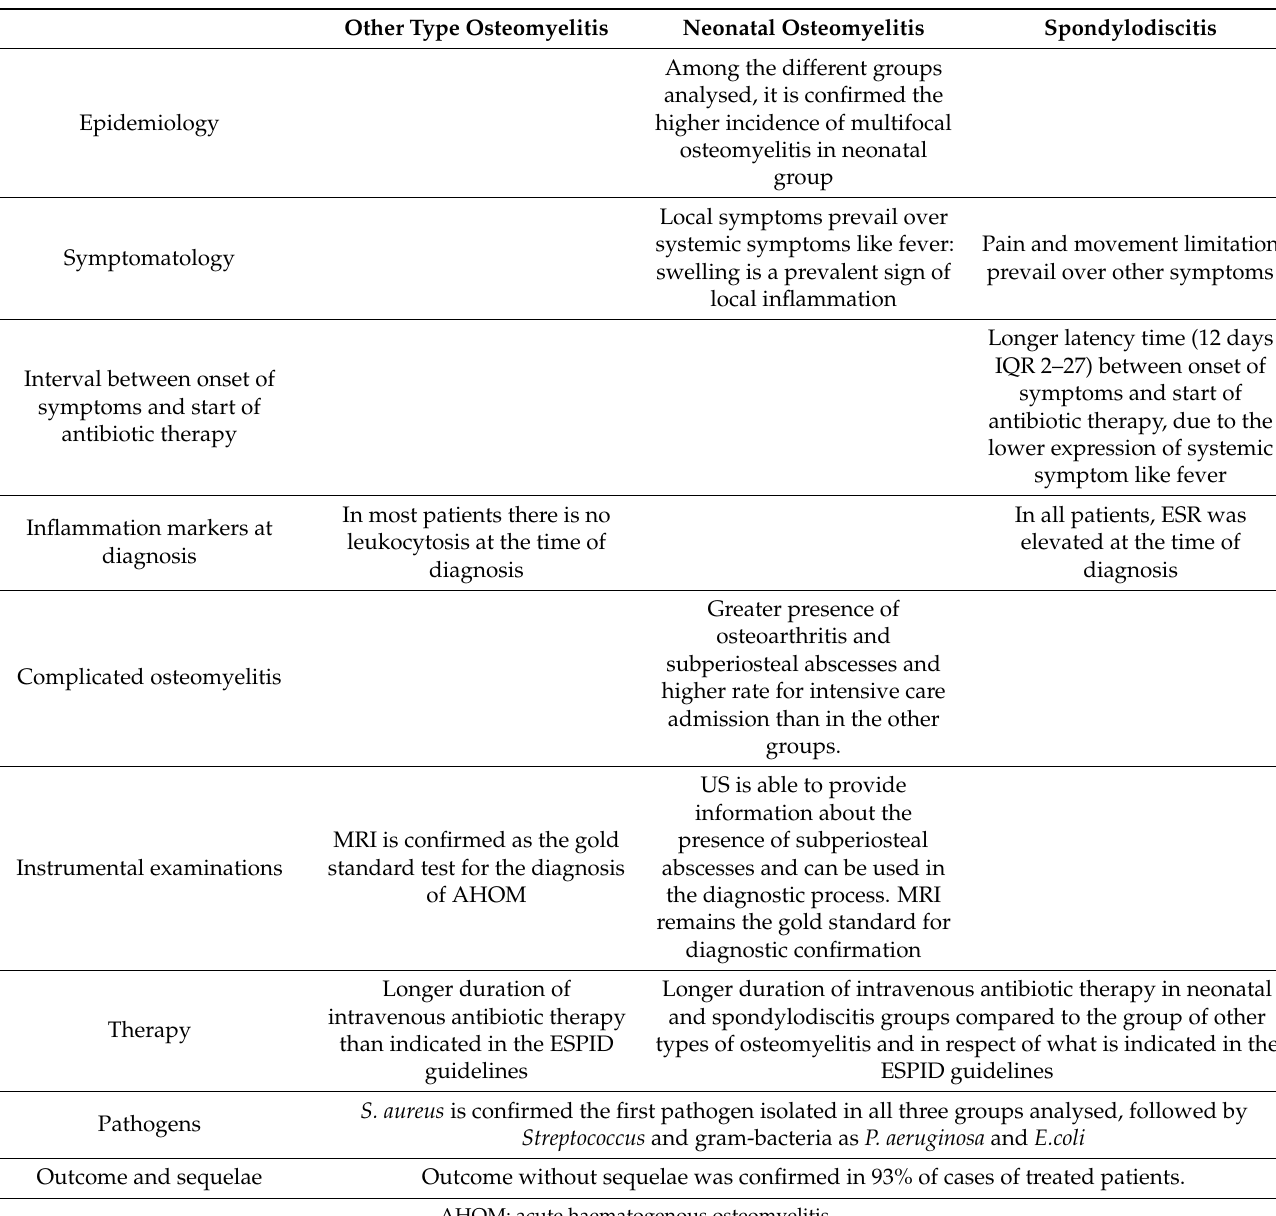
Table 7. Summary of